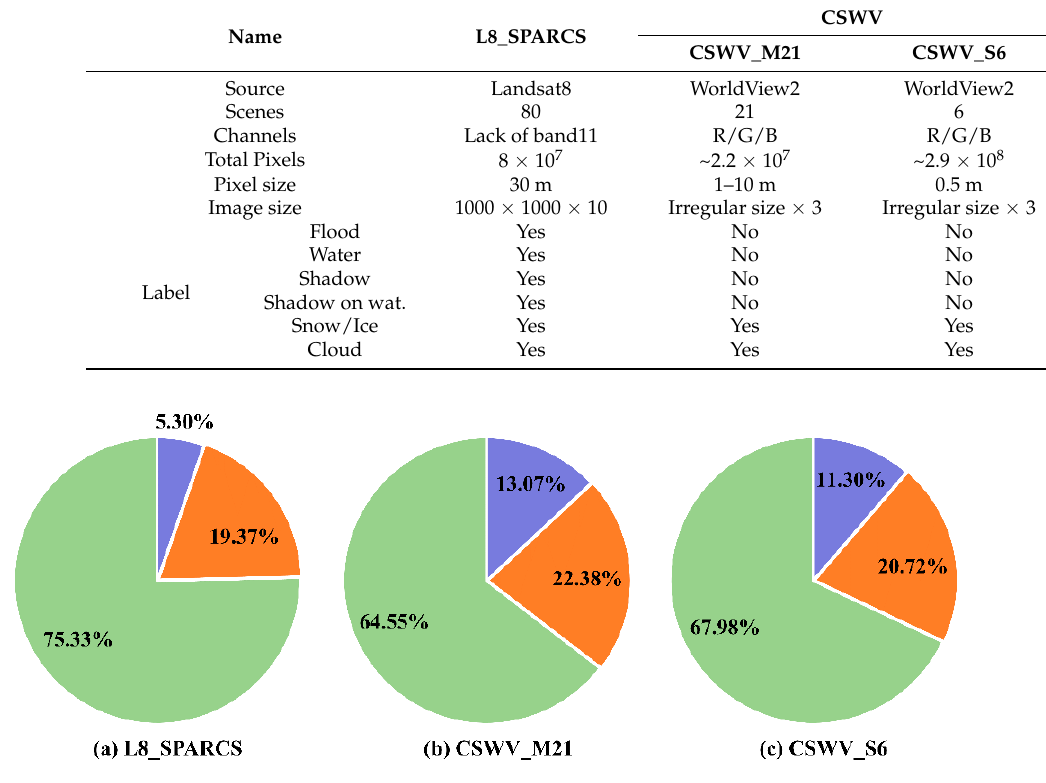
Table 1. The detailed information of L8_SPARCS, CSWV_M21, and CSWV_S6 datasets.